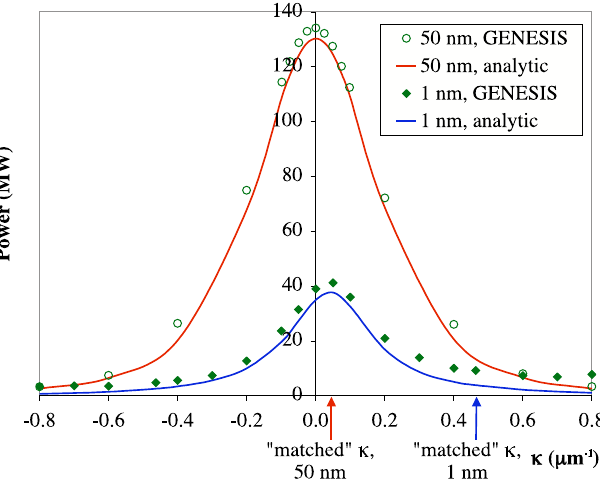
FIG. 4. (Color) Comparison of analytic theory with simulations using GENESIS . Results are shown for harmonic generation at 50 and 1.04 nm, as the conditioning parameter (cid:9) is varied. The matched values indicated refer to the ideal conditioning parame- ters for a different geometry, where the FEL output grows from noise, with no chicane.